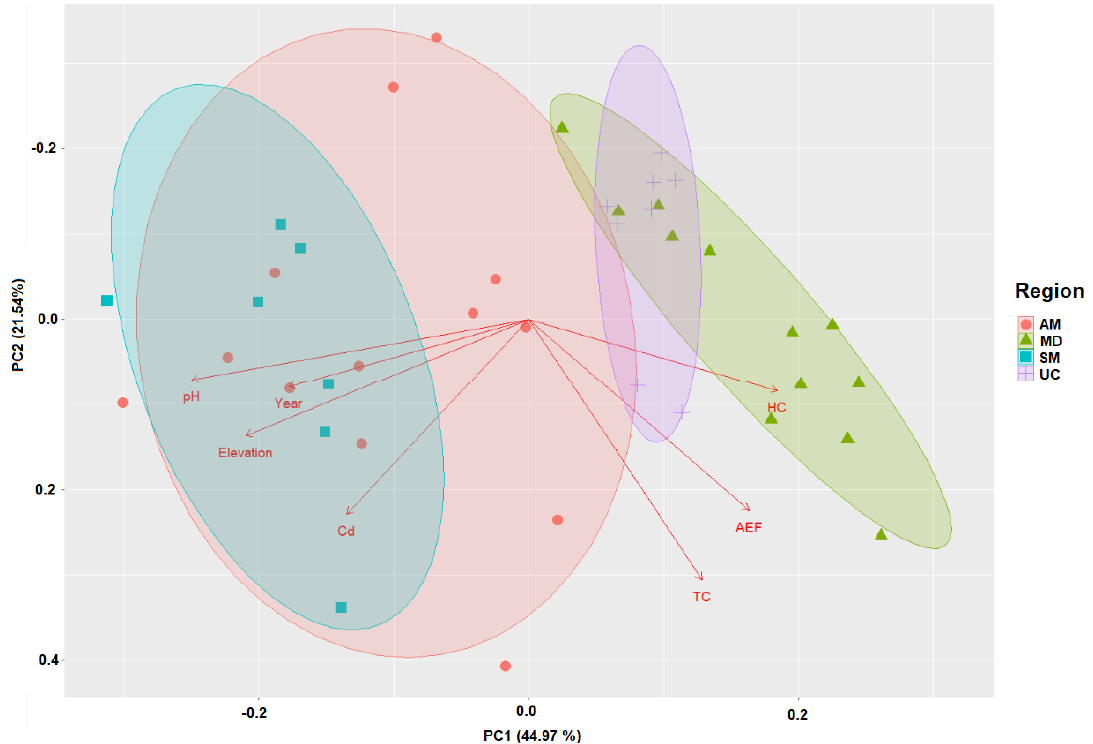
Figure 4. Biplot of the first and second axes obtained from the principal component analysis (95% confidence ellipses are shown) showing dependencies between site, soil and agroecological factors across regions. Points represent soil samples ( n = 40). Cd = Cadmium; TC = tree coverage; HC = herbaceous coverage; Year = year of plantation; AEF = agroecosystem functionality. Regions: Amazonas (AM), Madre de Dios (MD), San Martin (SM) and Ucayali (UC).